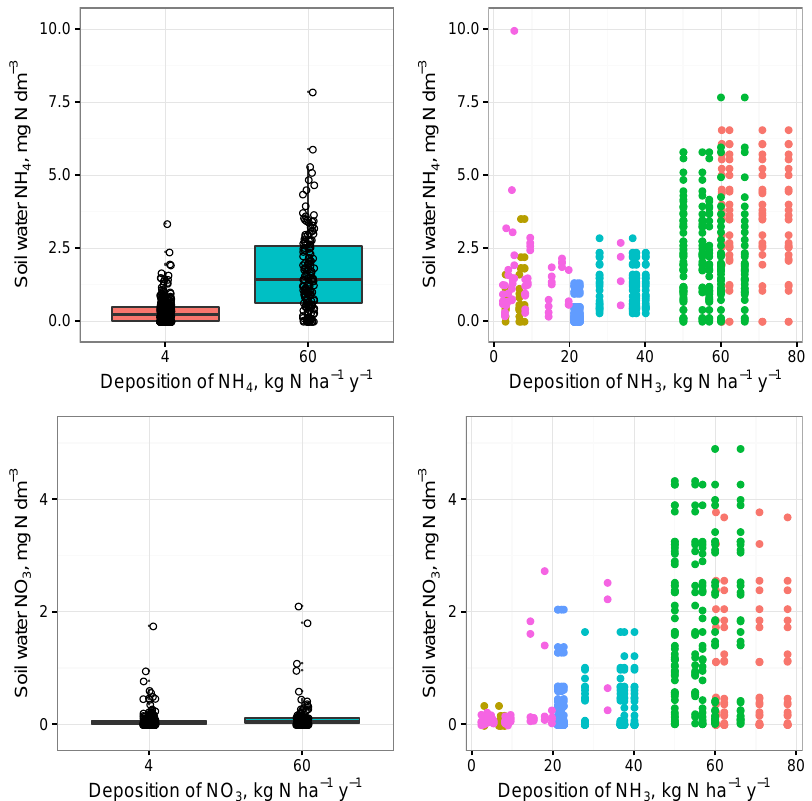
Figure 5. NH + and NO − concentrations in the soil water in the experimental treatments. In the right-hand plots, colours show measurements 4 3 grouped by distances downwind of the fumigation